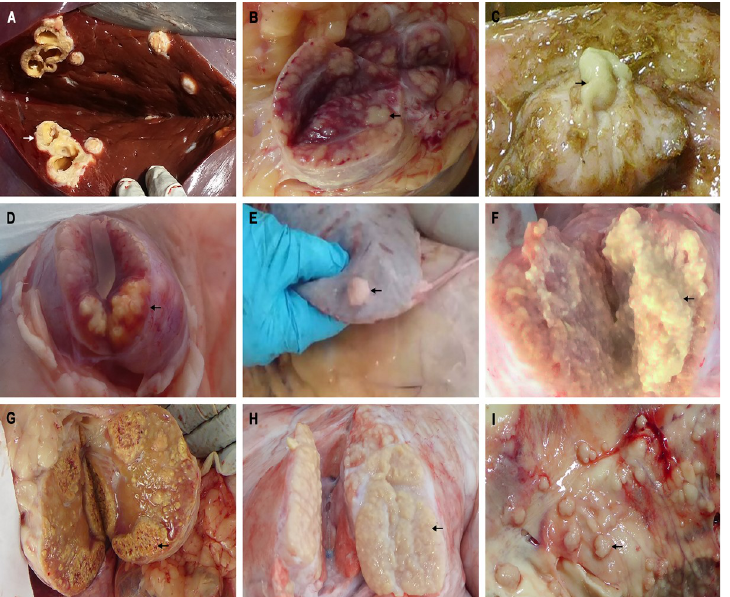
Fig 2. Lesions observed by necropsy. (A) Extensive cavitary lesions in liver. (B) Granulomas with caseous necrosis in mammary lymph node. (C) Granulomas with caseous necrosis in gastric lymph node. (D) Granulomas with caseous necrosis and mineralization in mesenteric lymph node. (E) Tuberculous granuloma in spleen. (F) Granulomas with caseous necrosis and mineralization in intestinal lymph node. (G) Granulomas with caseous necrosis and mineralization in hilar lymph node. (H) Big granulomas with caseous necrosis and mineralization in lung. (I) Miliary generalised tuberculosis on the thoracic cavity pleura (tuberculous “pearls”).